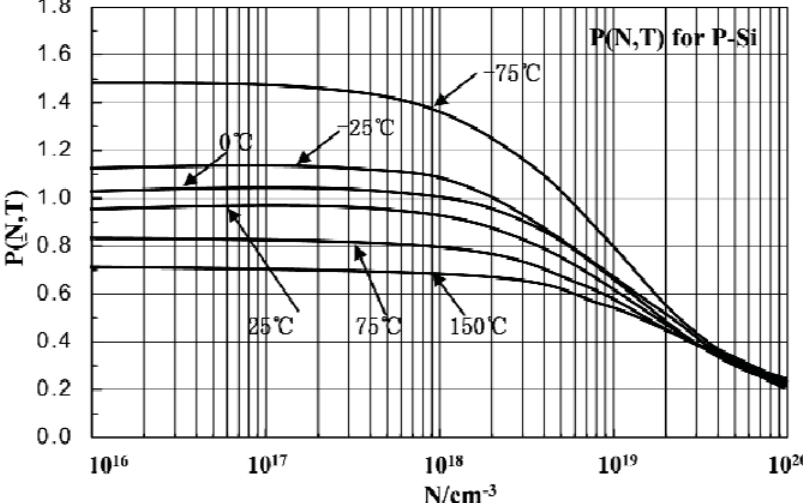
Figure 4. The piezoresistance coefficient versus boron ion doping dose and